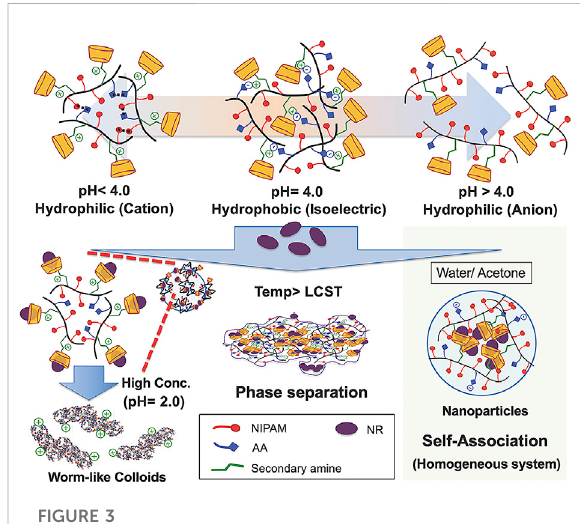
FIGURE 3 Colloidal assembly system comprising the poly (NIPAM-AA- β -CD) solution as a function of pH and temperature in both the homogeneous and inhomogeneous NR inclusion systems. Adapted with permission from Kawano et al.